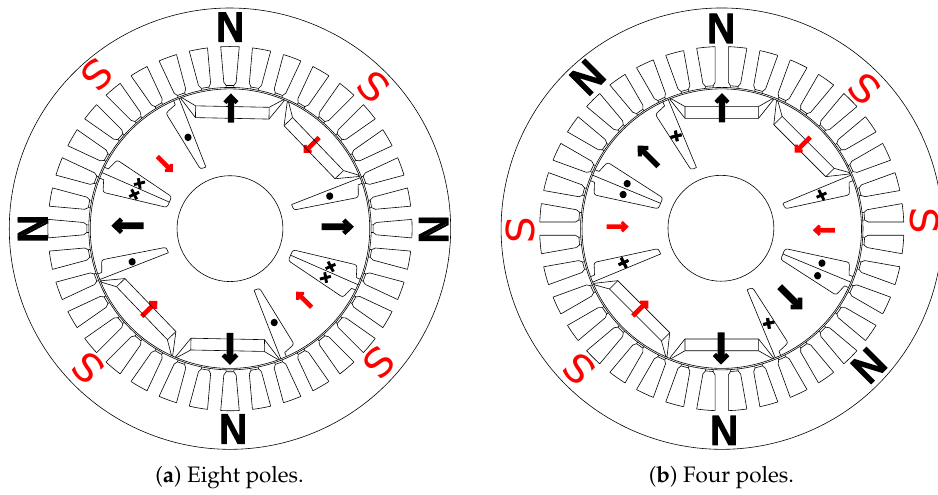
Figure 10. Change in polarity with reversing excitation